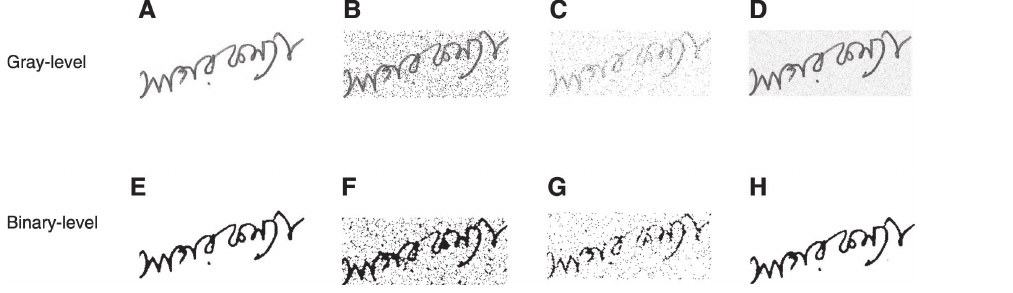
Figure 10: Instances of Gray-Level and Preprocessed Word Samples after Adding (A, E) No Noise (i.e. Actual), (B, F) Salt and Pepper, (C, G) Gaussian, and (D, H)